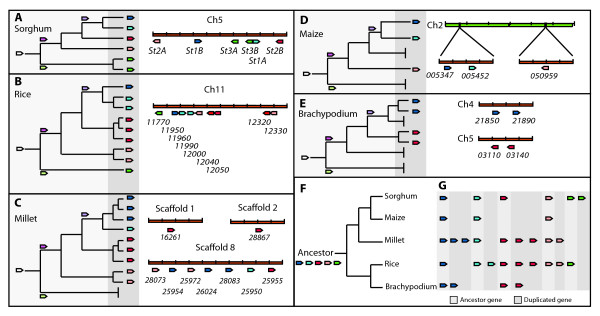
Evolution of St R-gene cluster in monocots species. Chromosome location, duplication and ancestry of the St gene cluster in A. sorghum, B. millet, C. rice, D. maize, and E. Brachypodium. Events preceding, (light grey) and post speciation (dark grey) are shown. F. Proposed ancestral R-gene cluster composition using an ancestral tree of grass species adapted from Bowman et al. [55], and phylogenetic analysis of homologous genes in each species. Genes colored in relation to St genes as follows; St1 blue, St2 red, and St3 green. Gene information is listed in Additional file 2.